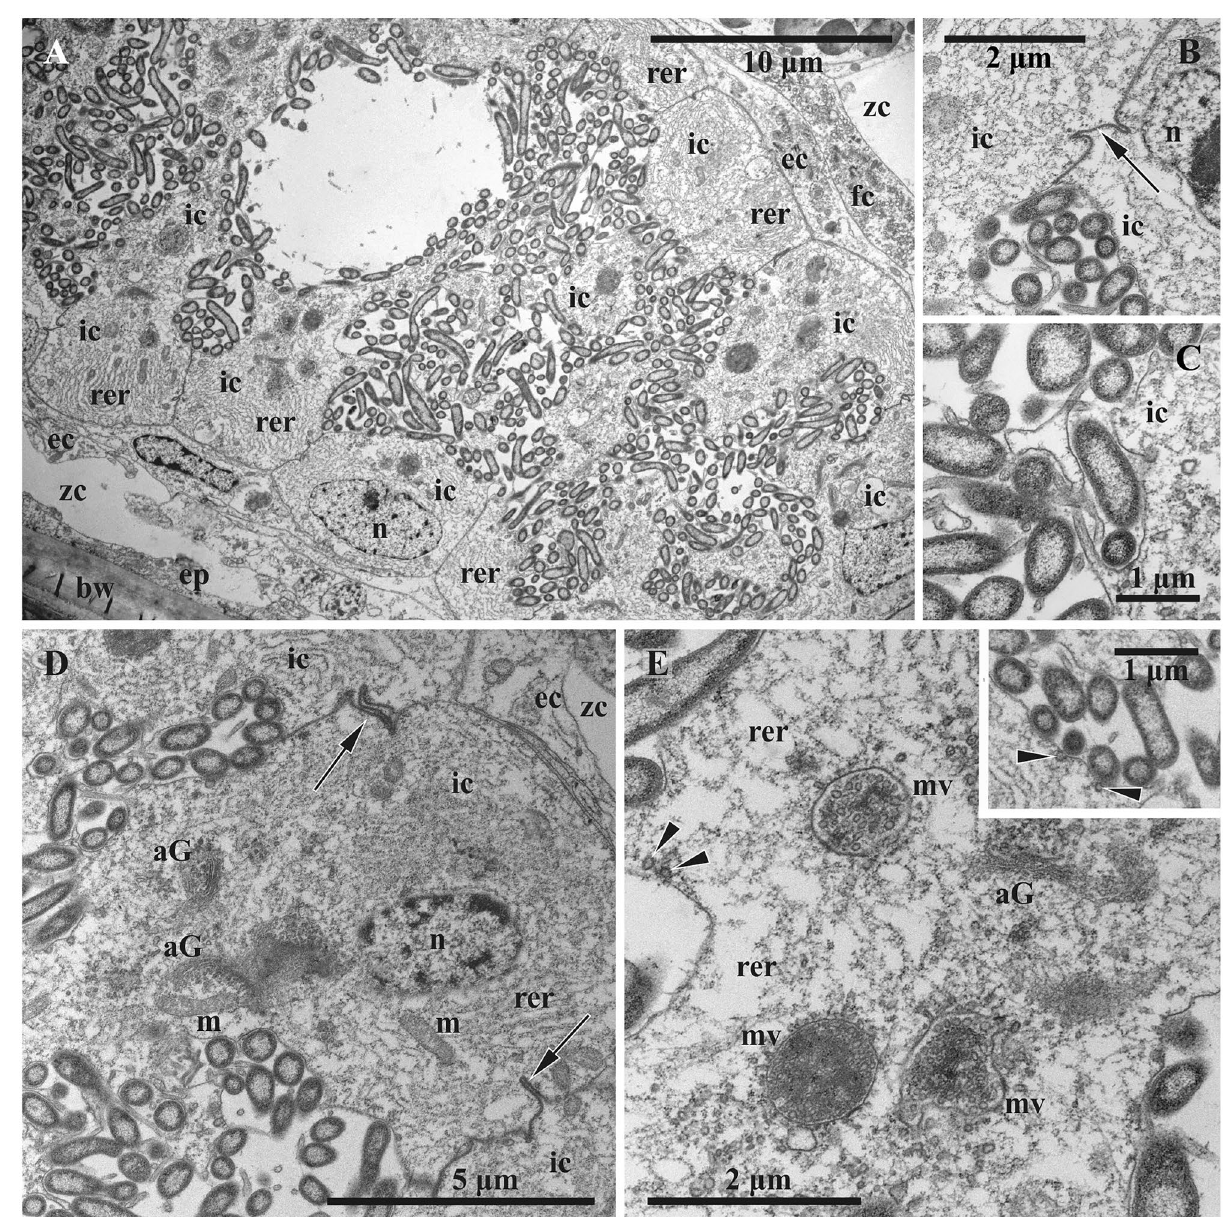
Figure 6. Ultrastructure of mature non-modified funicular body of Dendrobeania fruticosa (collected on 23 June 2018, also shown in Fig. 3C) (TEM). ( A ) Part of FB with two-layered wall and adjacent funicular cells; non-modified bacteria fill the internal space. ( B , C ) Area of internal cavity with bacterial symbionts and microvilli formed by cells of inner layer. ( D , E ) Details of ultrastructure of cells of inner layer; extensive RER, Golgi apparatuses and large multivesicular bodies in various stages of development are visible (inset and E : presumed exocytosis shown with arrowheads) (arrow: adherens junction with Z-curve between cells of inner layer in B and D ). aG Golgi apparatus, bw basal wall, ec cells of external layer, ep epithelium of body wall, fc cells of funicular cords, ic cells of inner layer, m mitochondrion, mv multivesicular body, n nucleus, rer rough endoplasmic reticulum, zc zooidal sizes (Fig. 7A, inset, F). In addition, tiny fibrils about 100 nm long and angular globules (presumably virus-like particles, see below) became visible in some areas of ILS (Fig. 7F). At the initial degradation stage, numerous bacteria, some apparently still dividing, filled the entire cavity of the FBs (Figs. 7A, 8A). However, the number of microvilli formed by the inner cells and present between bacteria, was significantly reduced. Microvesicles beneath the apical membrane of these cells were abundant, presumably indicating transmembrane transport. The morphology of bacteria changed too. Although the maximum length was still about 5 µm, many bacteria were about 1 µm in diameter. The most noticeable changes occurred in the bacterial nucleoid, which was fragmented and became smaller (Fig. 7A–C).